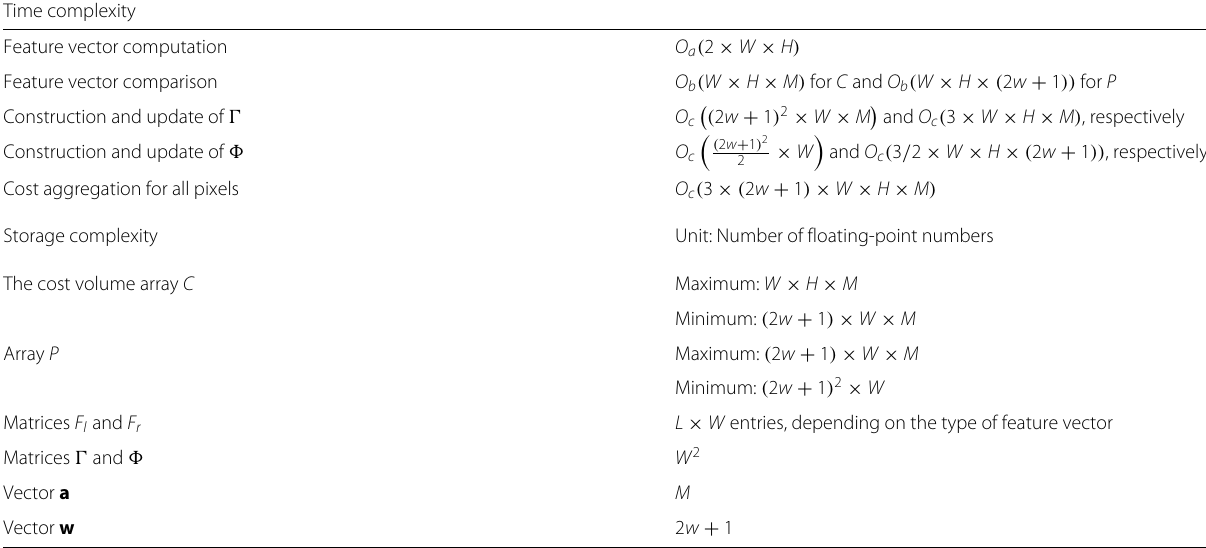
Table 1 Time and storage complexity of the proposed feature-vector-based cost aggregation algorithm Time complexity Feature vector